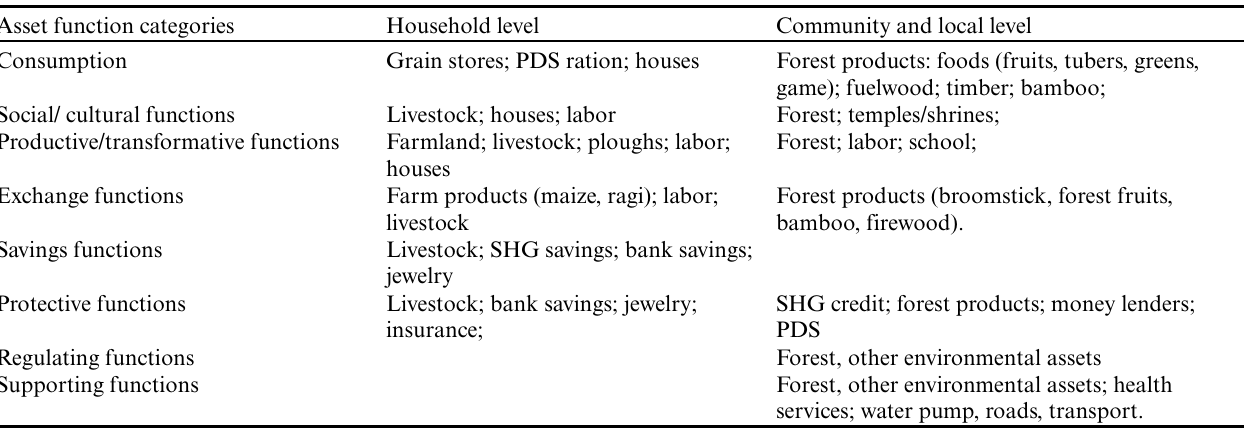
Table 2. Household and community / local-level assets fulfilling asset functions Asset function categories